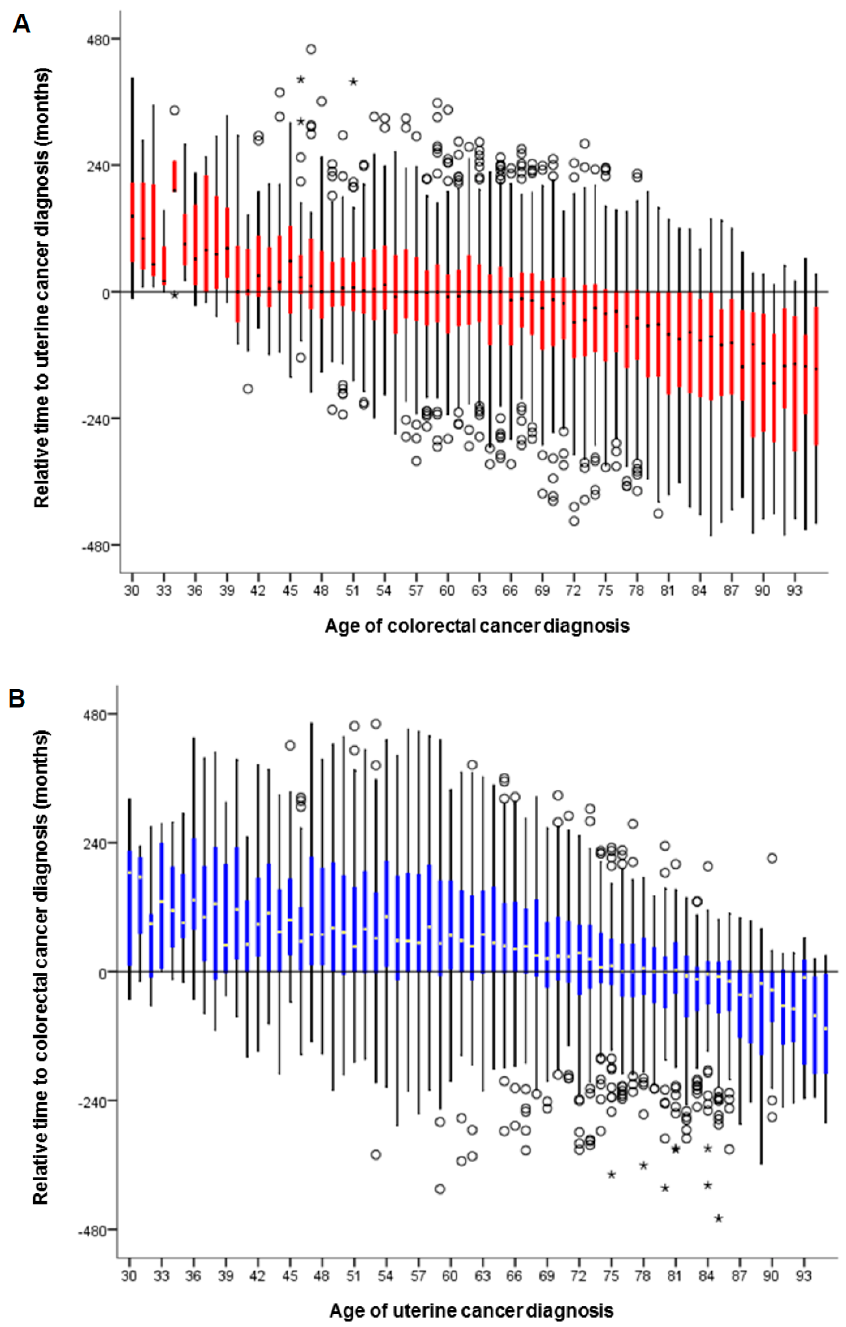
Figure 4. Relative time to secondary primary cancer per age. Among 6811 women who had the two cancer diagnoses, relative time to secondary primary cancer is displayed per age at the index cancer diagnosis. ( A ) Relative time to uterine cancer diagnosis is shown per age of colorectal cancer diagnosis. The first age that the median relative time interval became zero was 40 years. ( B ) Relative time to colorectal cancer diagnosis is shown per age of uterine cancer diagnosis. The first age that the median relative time interval became zero was 76 years.